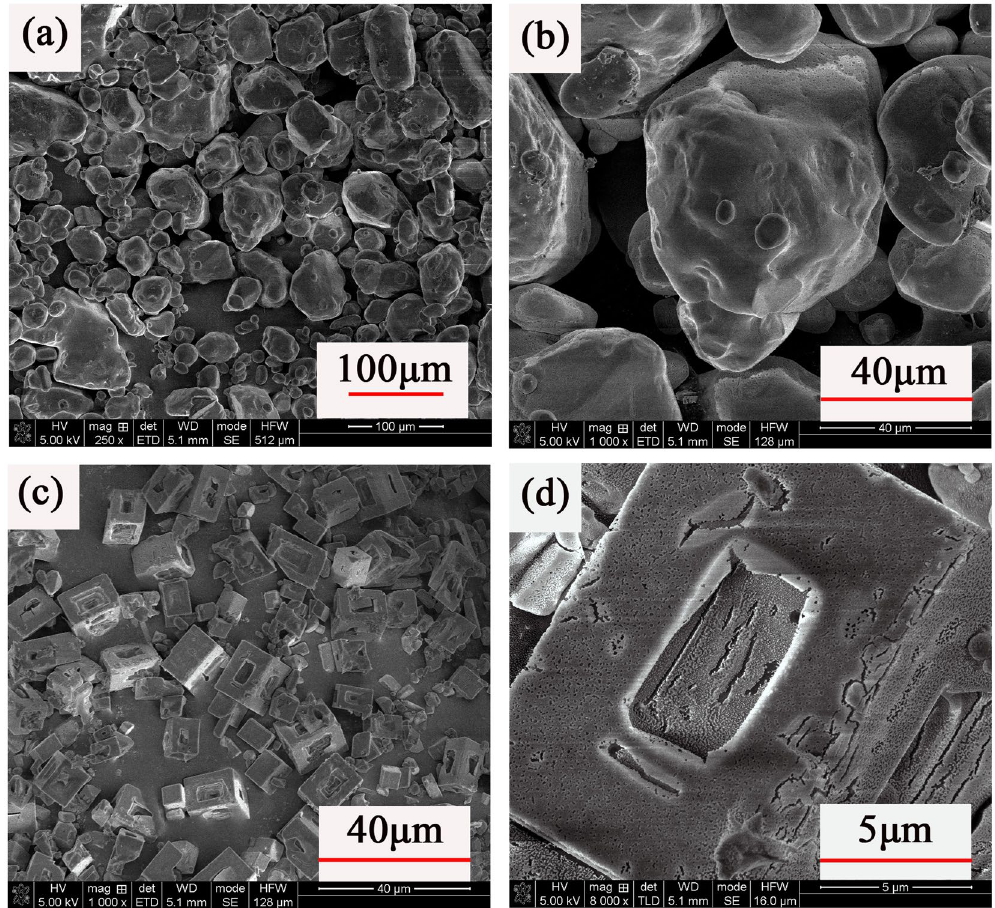
Figure 2. ( a ), ( b ) SEM images of raw Kp particles at 250x, 1000x ( c ), ( d ) SEM images of Kp particles synthesized by the condition of Kp water solution(1% w/v) added to 200-proof ethanol at 1000x,